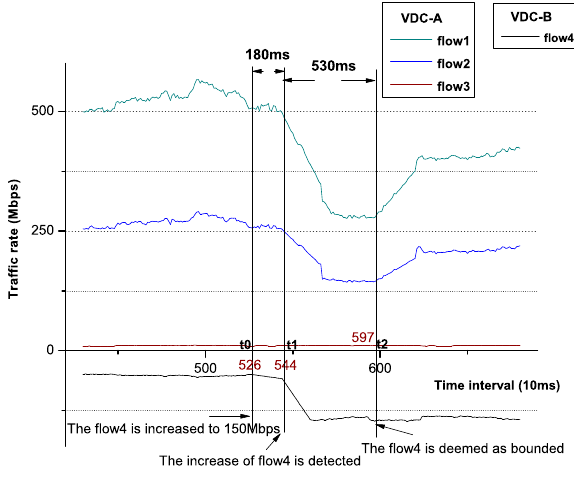
Figure 15. Detailed rapid bandwidth recovery in [t0,